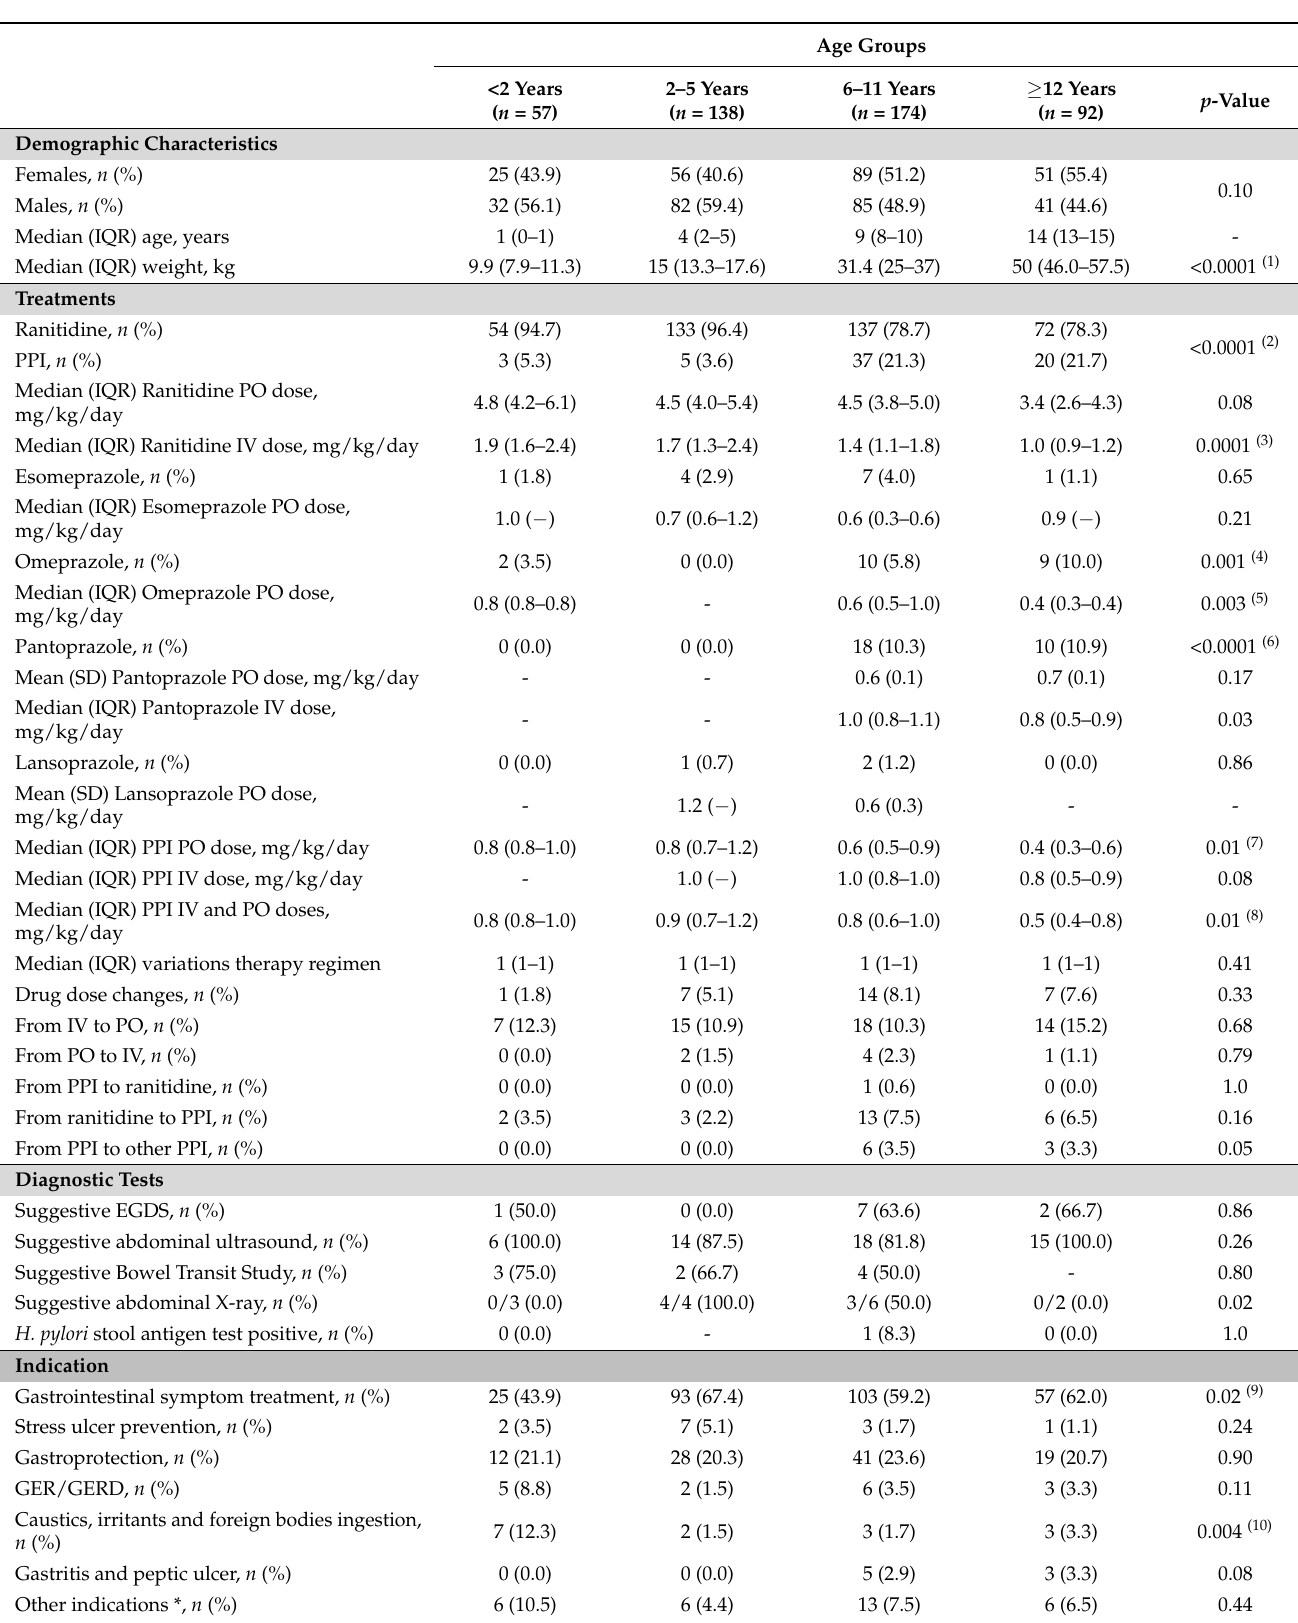
Table 2. Demographic, clinical and treatment characteristics of the study population stratified by age